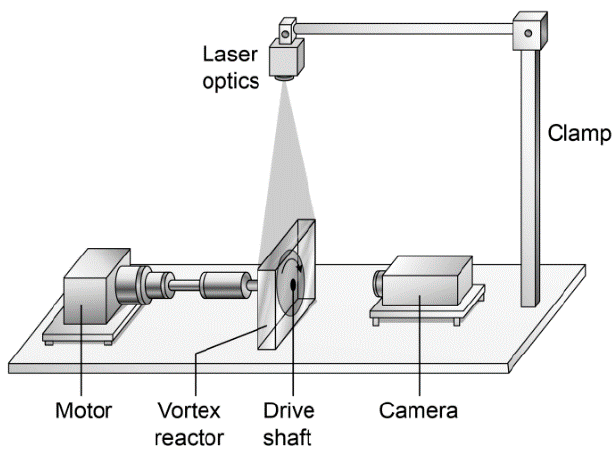
Figure 2. Schematic illustration of the Particle Image Velocimetry (PIV) set-up.